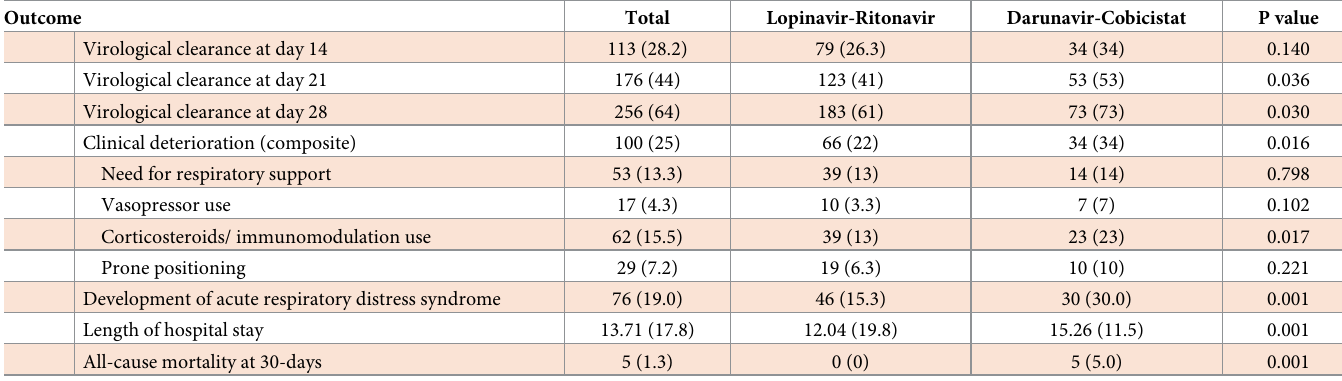
Table 3. Results of the secondary